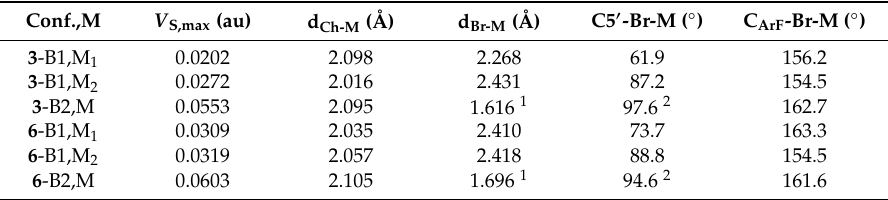
Table 3. V S,max (au) and geometrical parameters of σ -holes (M) located on the elongation of C ArF –Ch bond in 3 -B1, 3 -B2, 6 -B1, and 6